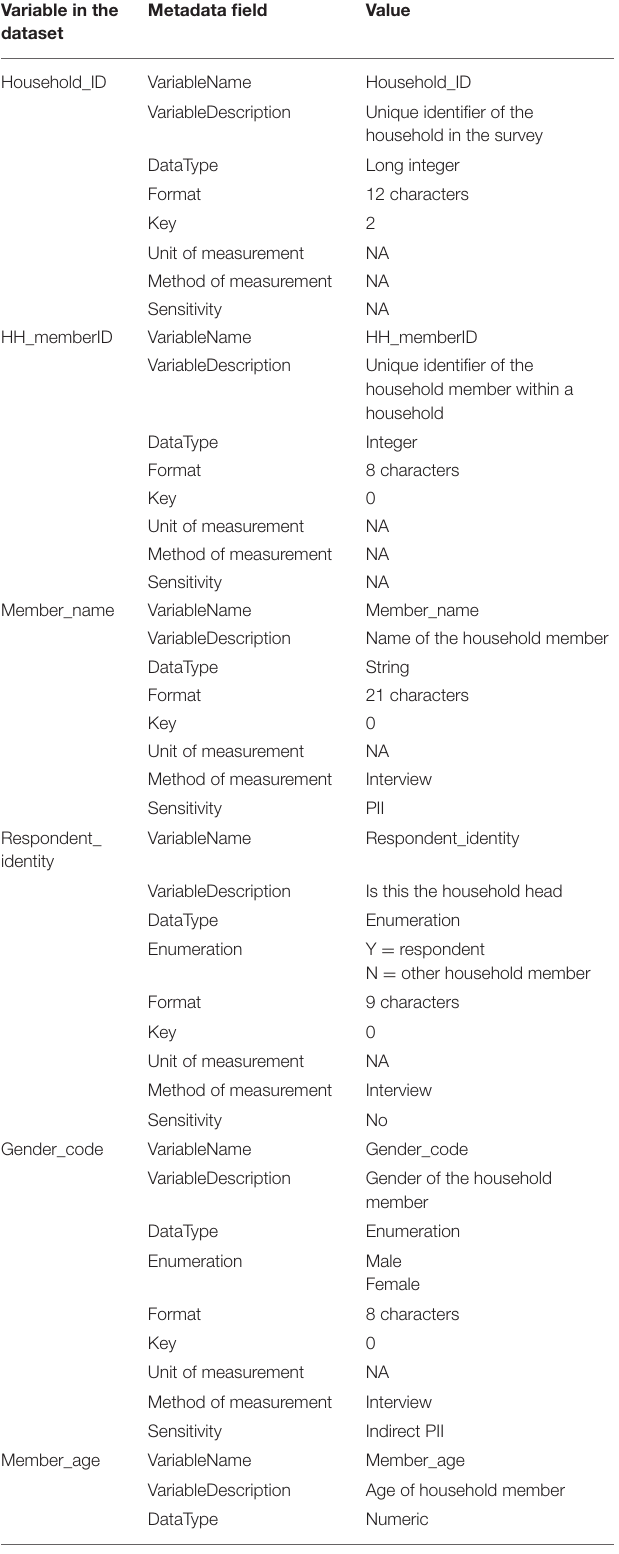
TABLE 1 | Data dictionary of single primitive fields and simple enumerations. Variable in the